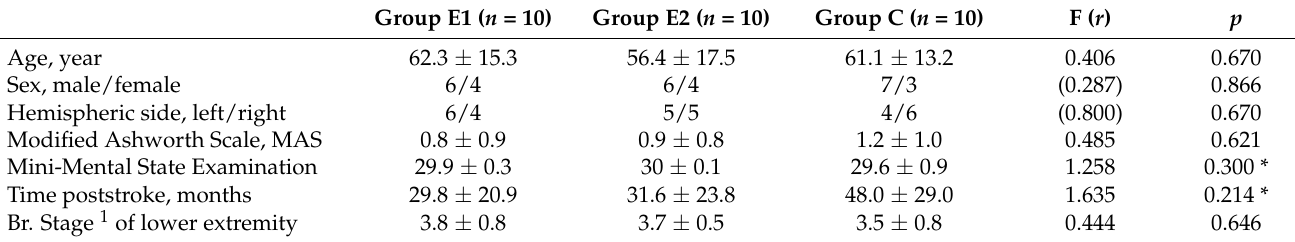
Table 1. Participant characteristics.